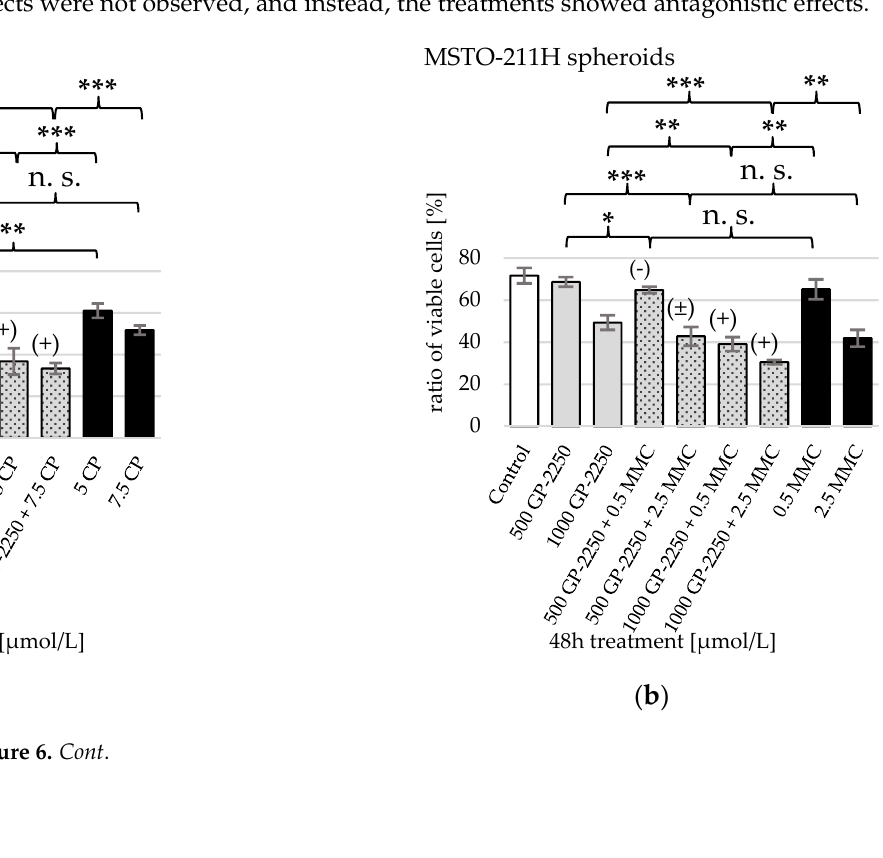
( e ) Figure 6. Analysis of cytotoxicity via flow cytometry after 48 h combination treatments. The graphs display the ratio of viable cells of ( a ) MSTO-211H sph. treated with GP-2250 + CP, ( b ) MSTO-211H sph. treated with GP-2250 + MMC, ( c , d ) JL-1 sph. treated with GP-2250 + CP, ( e ) JL-1 sph. treated with GP-2250 + MMC. Cells were marked with annexin V-FITC/ PI dual-binding, following the measurement of viable, apoptotic and necrotic cells via flow cytometry. Values are means ± SD of at least 3 independent experiments with consecutive passages. Asterisk symbols indicate the statistical significance between the combination-treatment and their respective monotherapies. *** p ≤ 0.001, ** p ≤ 0.01, * p ≤ 0.05, n.s. p > 0.05 (unpaired t-test). The combination indices (CI) by Chou- Talalay are marked as followed: CI < 0,9: symbiotic effect (+), CI = 0.9–1.1: additive effect (±) and CI > 1,1: antagonistic effect (-). Concerning the moiety of necrotic and apoptotic cells of JL-1 sph., none of the combinations proved to show a significant increase of the shares of necrotic or apoptotic cells in comparison to each monotherapy.